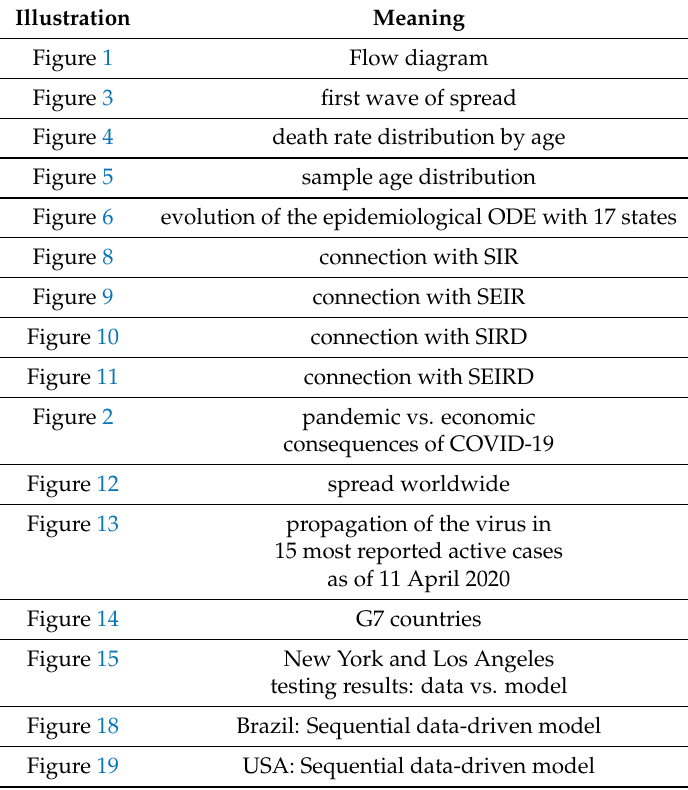
Figure 17. Another COVID-19 sample of Non-Gaussianity and non-exponential. The plots are obtained by using the data set sequentially till the latest data point. A Non-Gaussianity of the reported active cases and hospitalized cases is observed. The shape of the sequential data-driven curve is clearly not a single exponential.